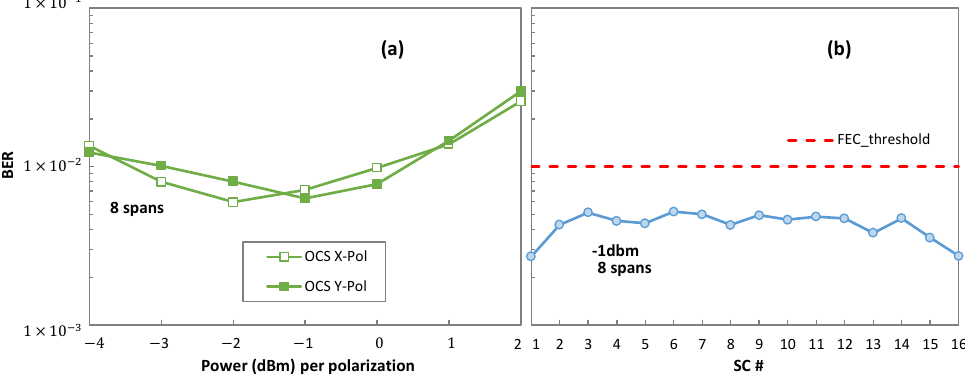
Figure 8. Details of optical performance of OCS ( a ) and DSCM ( b ).